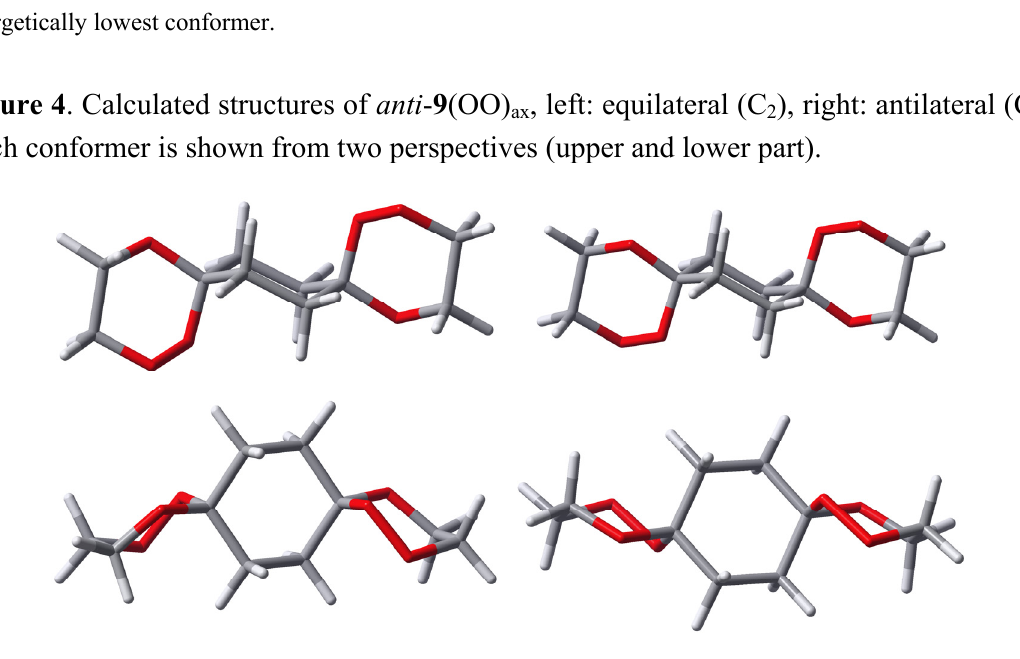
, left: equilateral (C ), right: antilateral (C ax 2